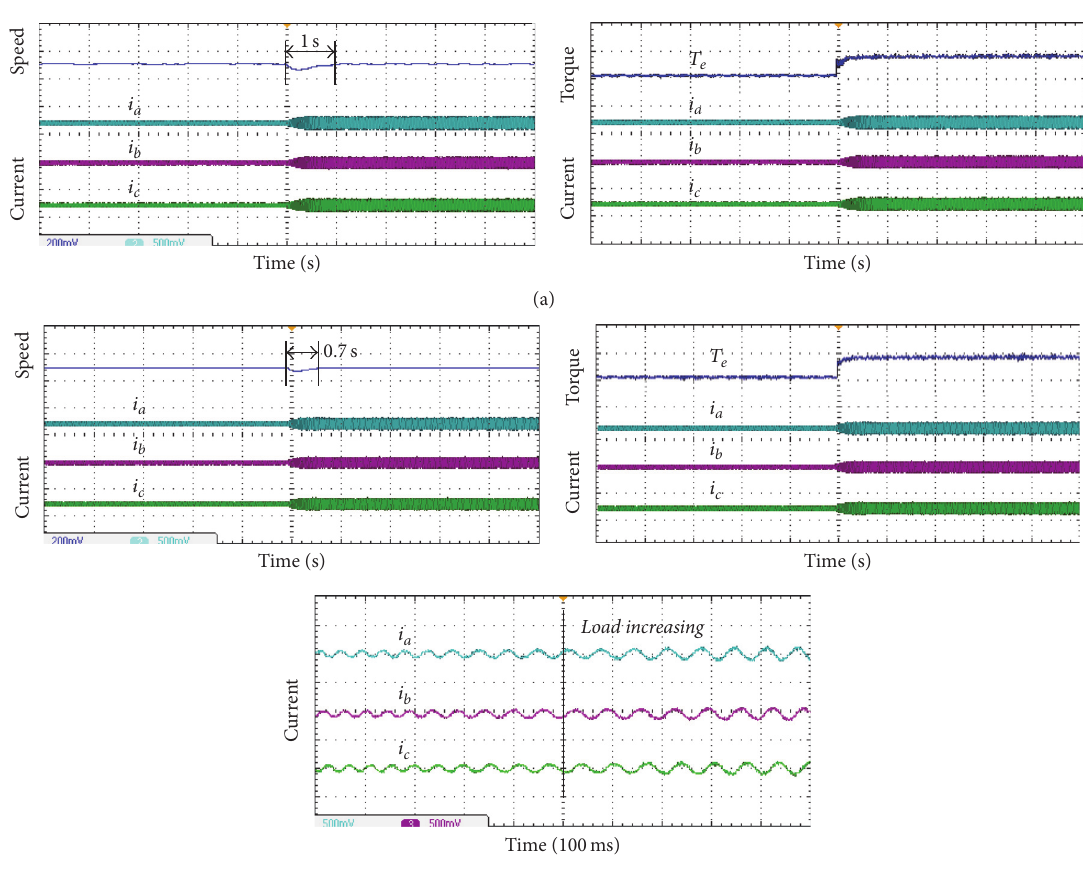
Figure 14: Response when the load suddenly increases (current (1A/div), speed (200 r/min/div), torque (2N ⋅ m/div), and time (1s/div)). (a) The existing SMC control strategy. (b) The proposed SMC control